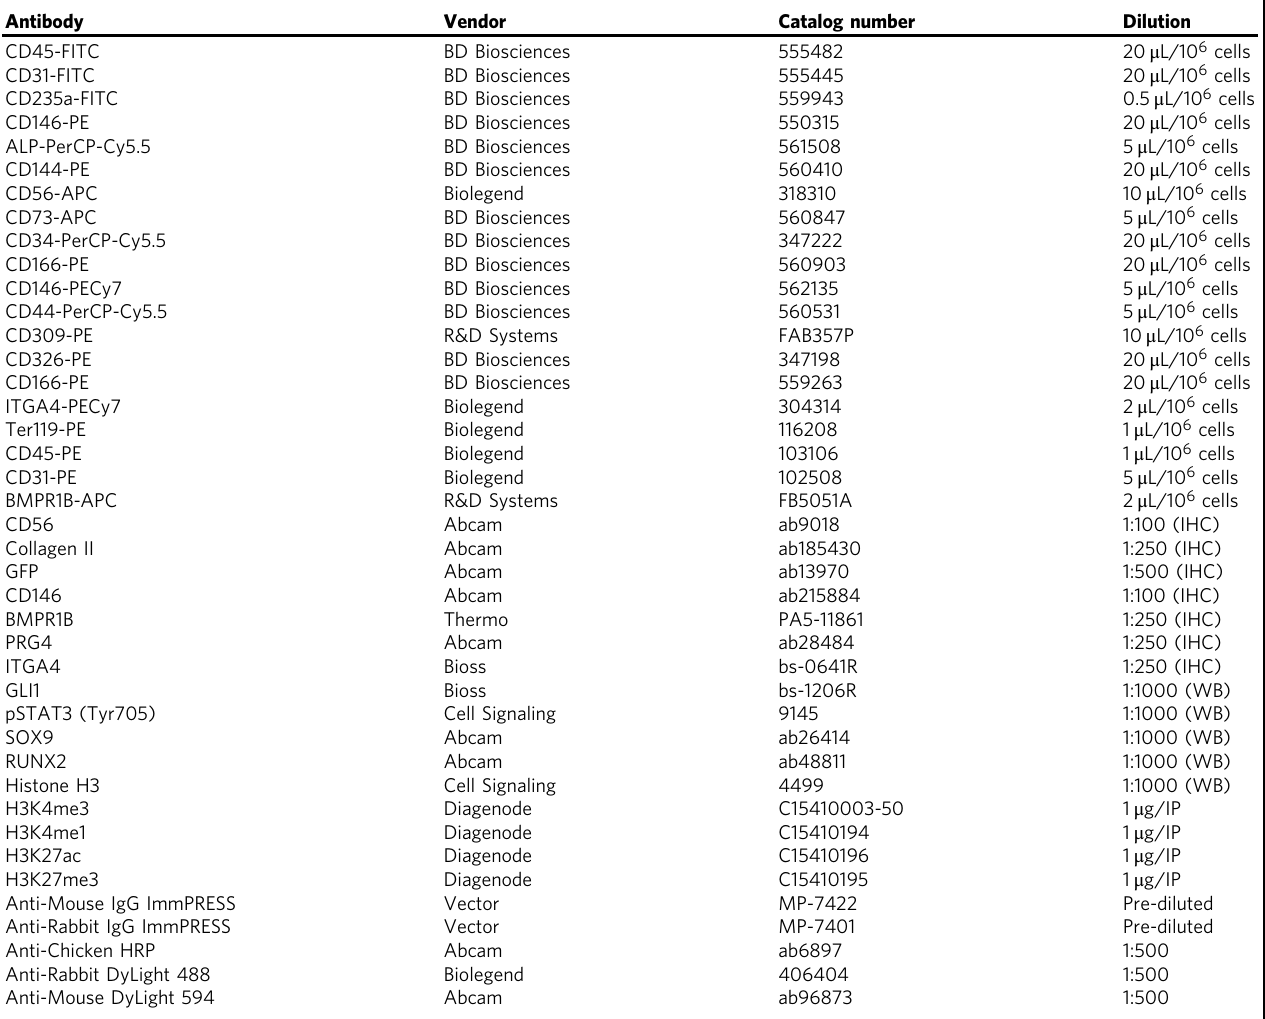
Table 1 Antibodies used in this